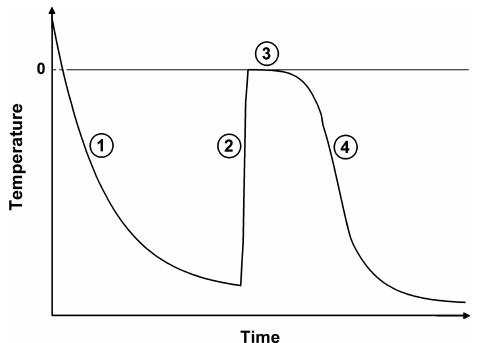
Figure 1. Schematic plot of the temporal surface temperature evolu- tion of a freezing droplet. (1) Supercooling of the liquid droplet until nucleation is initiated; (2) adiabatic-freezing stage, where rapid ki- netic crystal growth takes place until supercooling is exhausted. No heat exchange with the environment. (3) Diabatic-freezing stage, in which ice crystal growth inside the droplet is governed by heat transfer with the environmental air; (4) cooling stage, where the ice particle cools down, adapting to the ambient